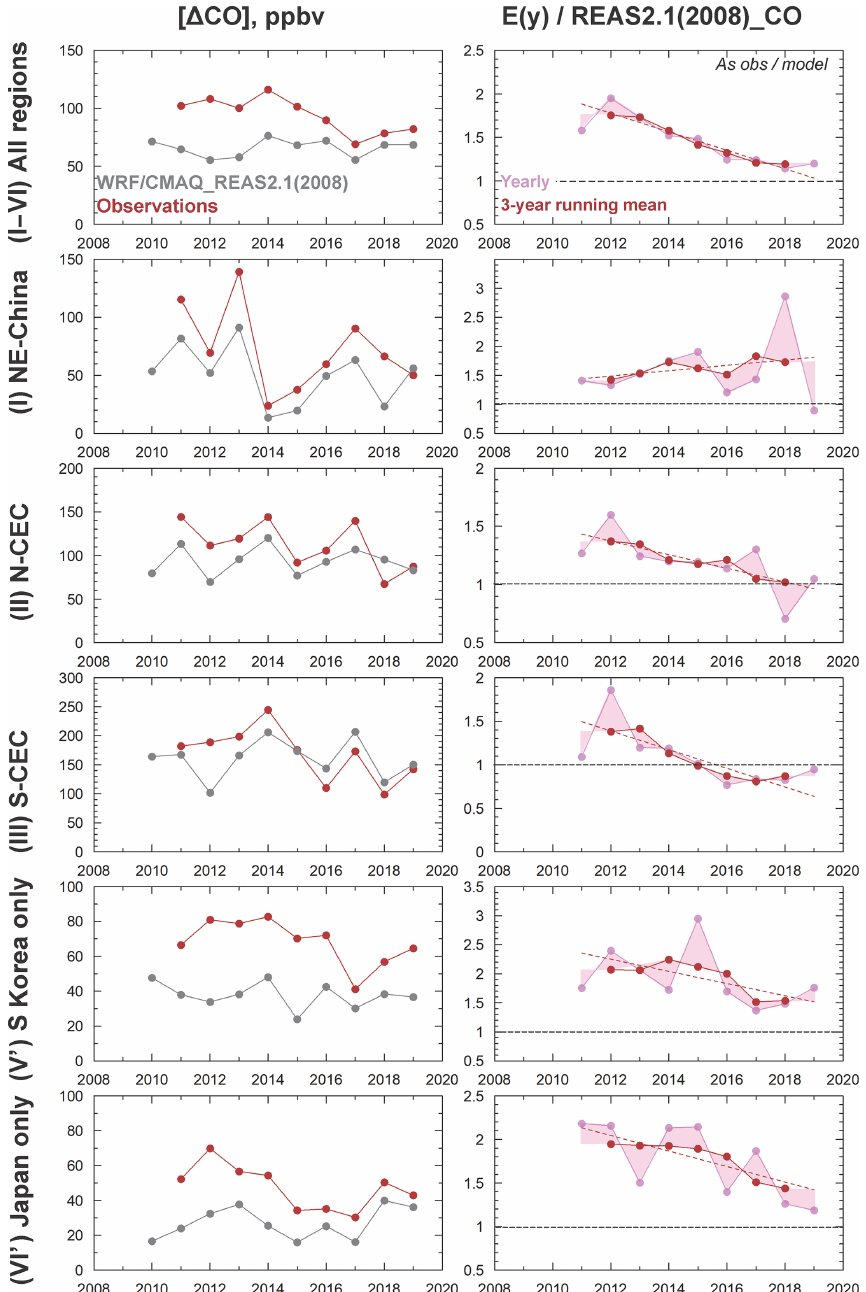
Figure 8. Same as Fig. 6 but for (cid:49) CO during winter (DJF). Emissions correction factor – E( y )/REAS2.1(2008); NE China – northeastern China; N-CEC – north-central East China; and S-CEC – south-central East China.